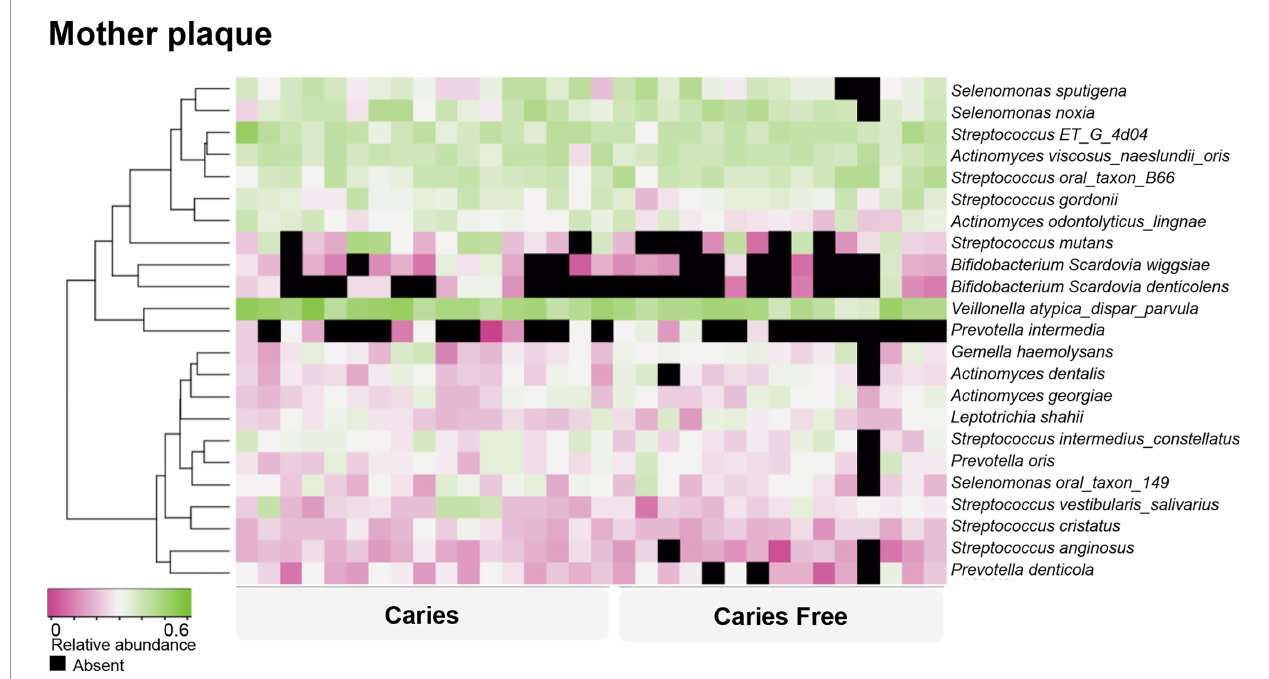
FIGURE 4 | Caries-associated and health-associated plaque microbiome in mothers. Based on their relative abundance, the supragingival plaque microorganisms were clustered into caries associated and caries-free – associated groups, as shown by the dendrogram on the left. Relative abundance is indicated by a gradient of shades from pink to green. Black spots indicate no detection of the